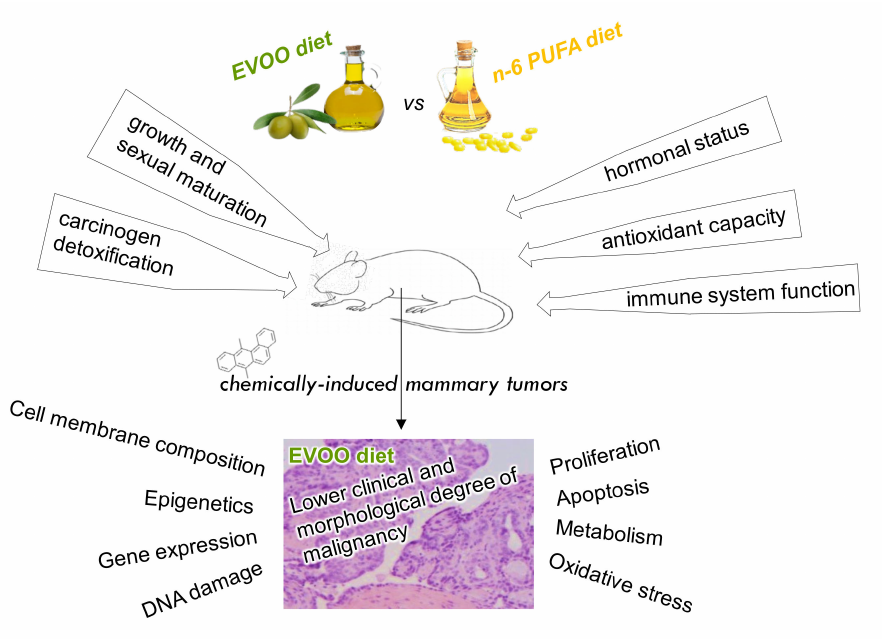
Figure 1. Effects and main mechanisms of action of high-EVOO diets, in comparison to high-seed-oil diets, on experimental mammary carcinogenesis. Animals fed the high-EVOO diet displayed tumors of lower clinical and morphological degree of malignancy. These effects can be related to systemic mechanisms influencing susceptibility and tumor initiation (growth and sexual maturation, liver capacity of carcinogen detoxification, hormone levels, antioxidant capacity and immune function), as well as molecular changes in tumors (in membrane composition, epigenetics, gene expression, DNA damage, oxidative stress, or metabolism, conducting cells to decreased proliferation and increased